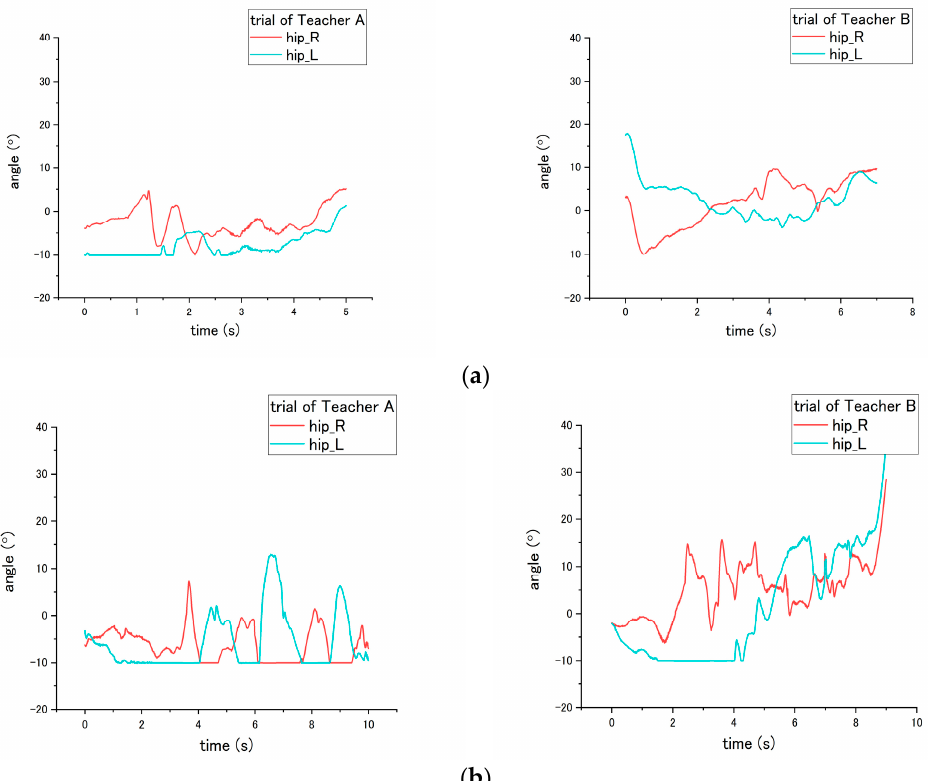
Figure 14. Flexion angle of patient’s hip during step No. 11 through the ( a ) correct way, and ( b ) incorrect way conducted at step No. 2.